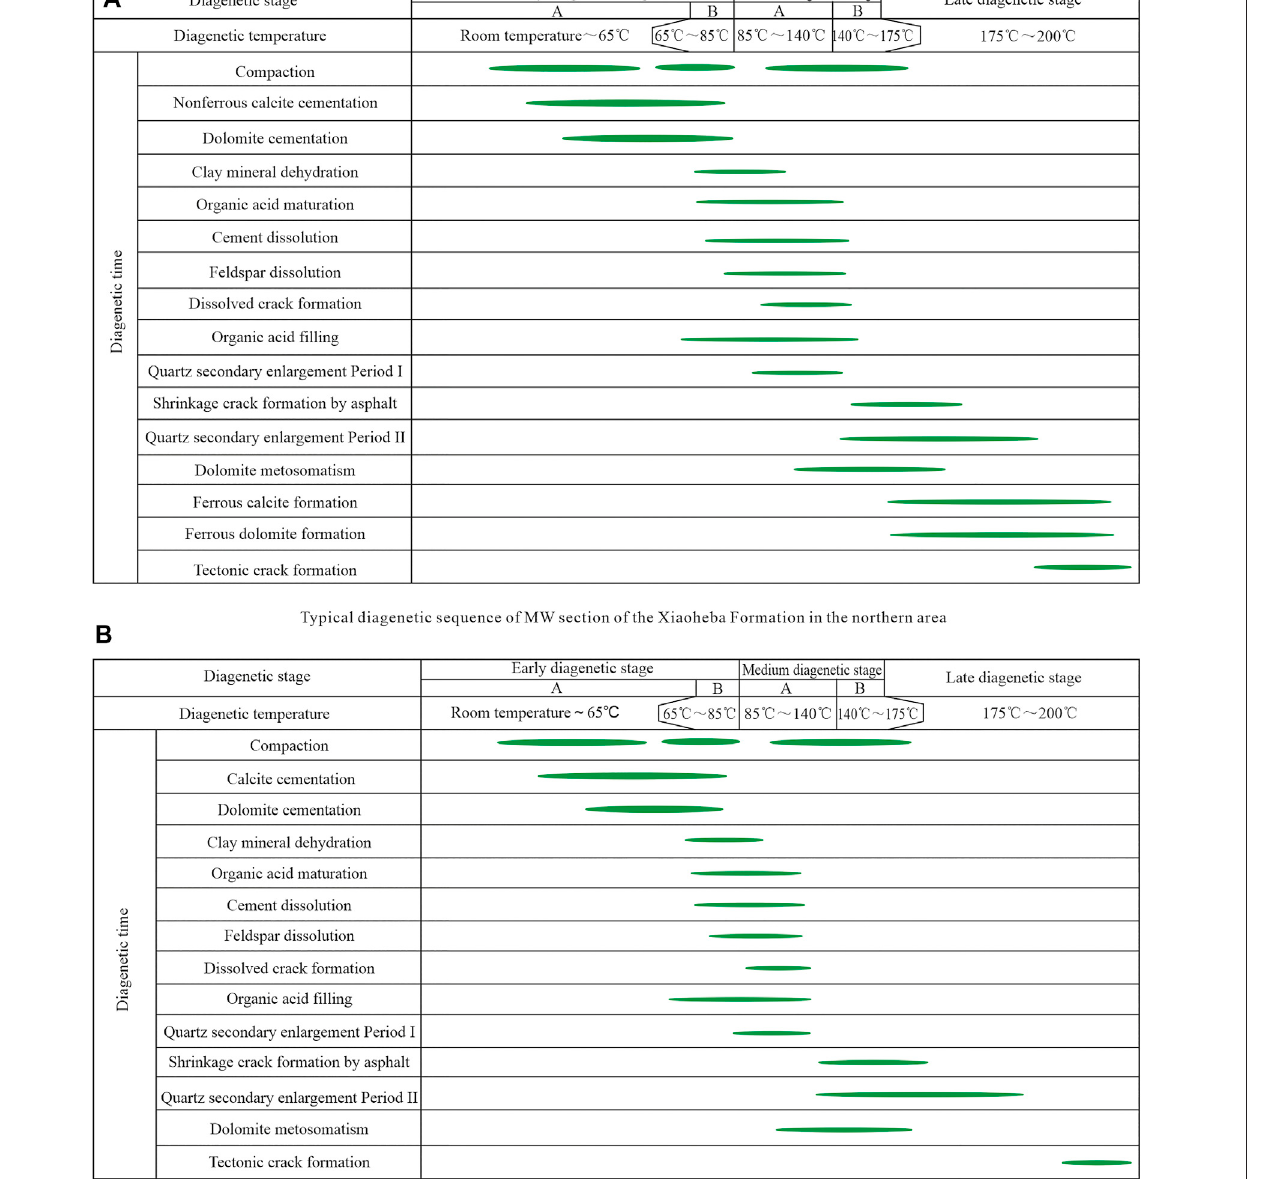
Frontiers in Earth Science |